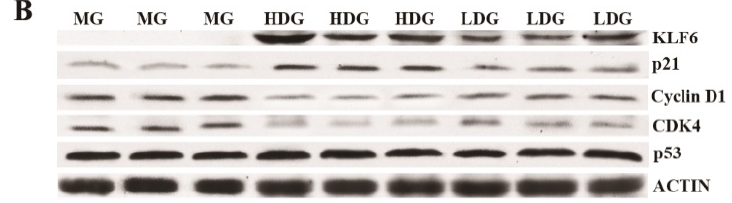
Figure 4. Effects of purified C3G on gene expression and protein expression in tumor xenografts. ( A ) Relative mRNA expression of KLF6 , p21 , CDK4 , Cyclin D1 , p53 after C3G treatments; ( B ) protein expression of KLF6, p21, CDK4, Cyclin D1, p53 after C3G treatments. Values are mean ± SEM of measurements from three mice. ** p < 0.01, *** p < 0.001.